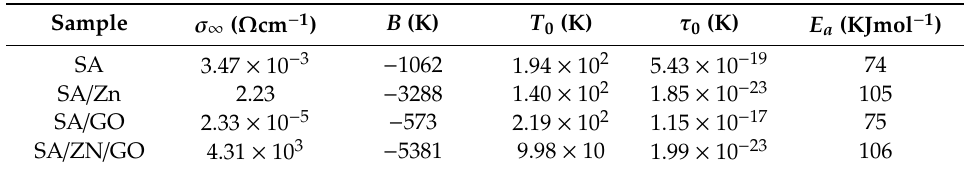
Table 2. VFT fitting obtained for dc-conductivity, σ 0 , obtained from σ ’ spectrum. Pre-exponential factor ( τ 0 ) and activation energy for the conductivity process ( E a ). Temperature interval for both fittings: 0 to 50 ◦